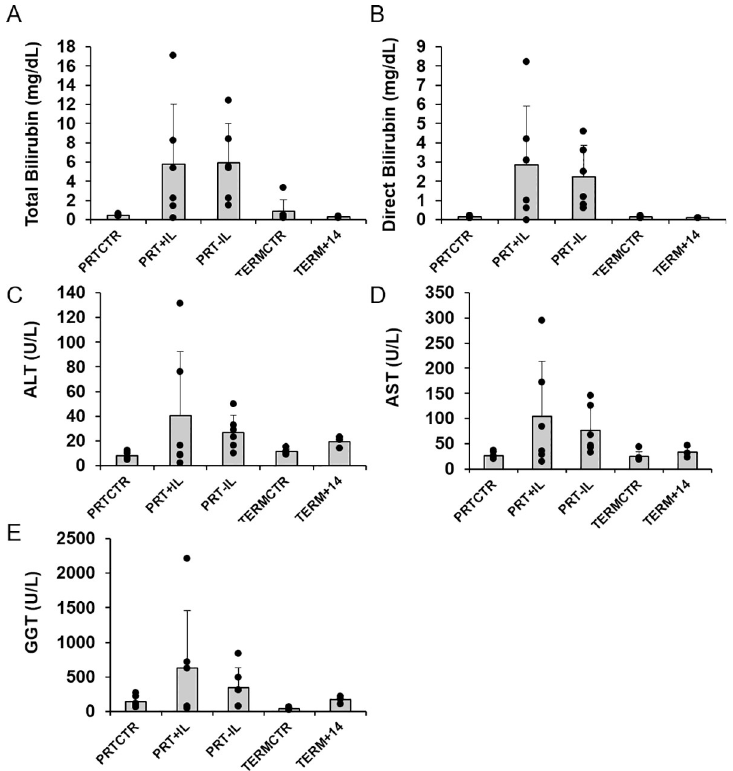
Fig 1. Serum levels of traditional liver function tests in infant baboons. Mean serum [A] Total Bilirubin (in mg/dL), [B] Direct Bilirubin (in mg/dL), [C] Alanine aminotransferase (ALT, in U/L), [D] Aspartate aminotransferase (AST, in U/L) and [E] Gamma-glutamyl transferase (GGT, in U/L) are shown for each group. Error bars represent ± SD. � , P < 0.05, significance is based on one-way ANOVA with Bonferroni Post-Hoc. PRTCTR: preterm gestational control, n = 6; PRT+IL: preterm with Intralipids, n = 6; PRT-IL: preterm without Intralipids, n = 6; TERMCTR: term gestational control, n = 6; TERM+14d: term gestational control surviving 14 days, n = 3.